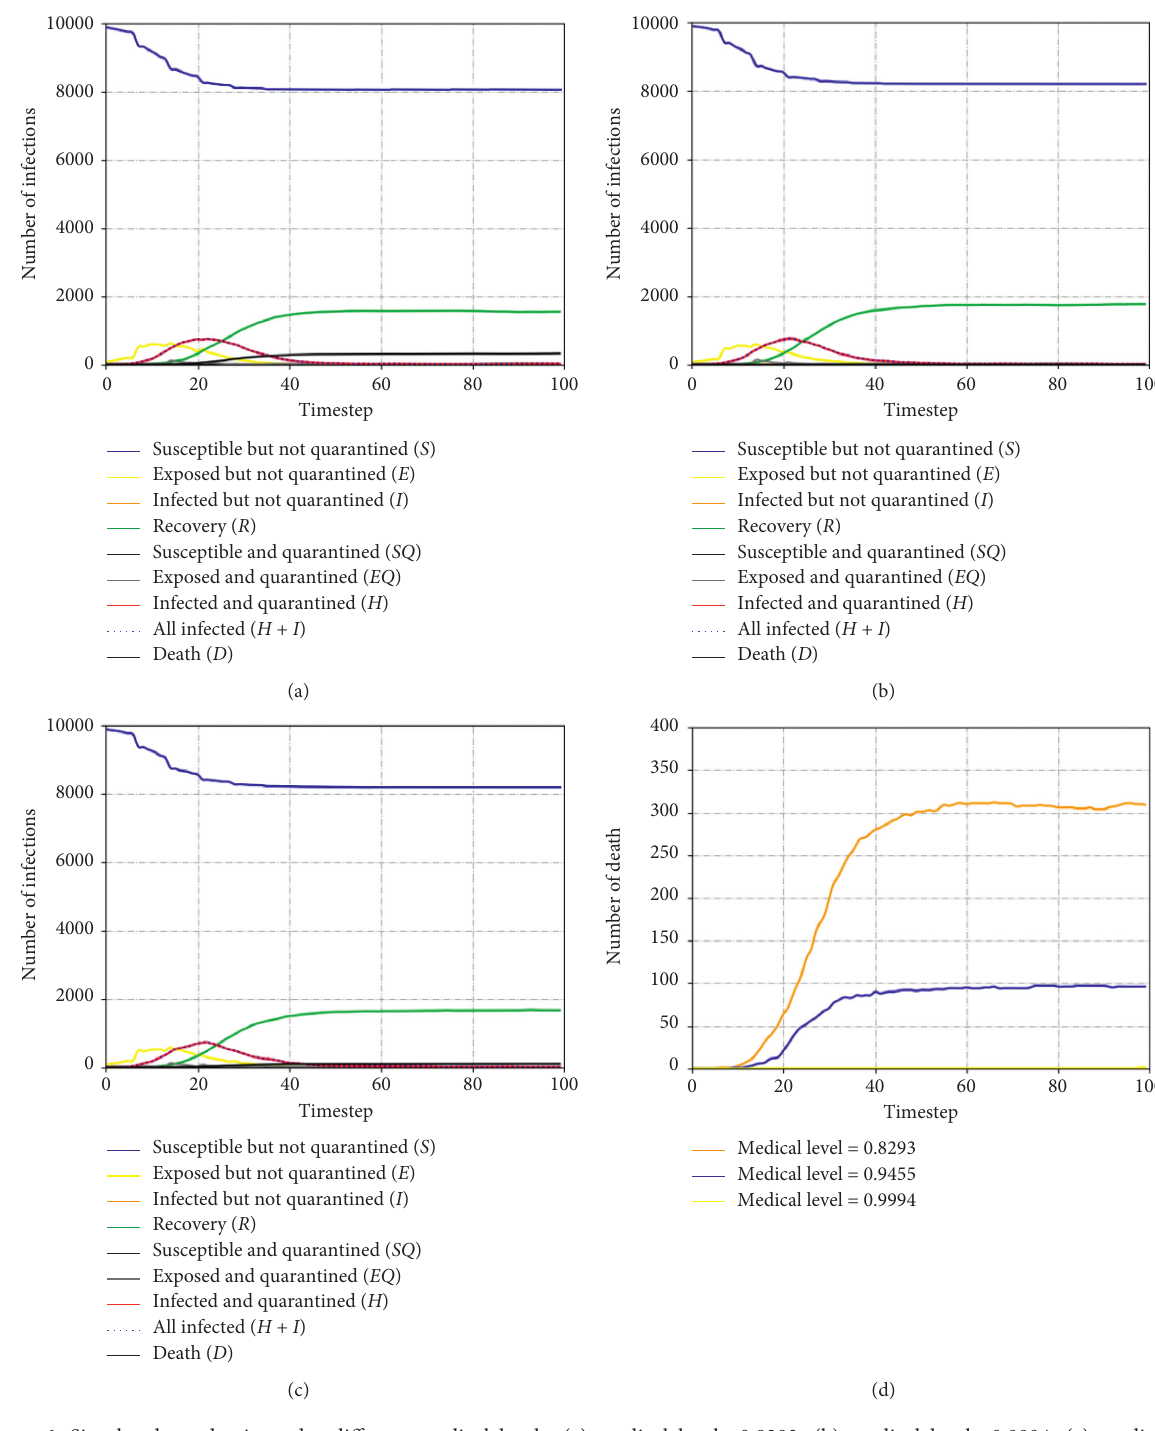
Figure 6: Simulated pandemic under different medical levels: (a) medical level � 0.8293; (b) medical level � 0.9994; (c) medical lev- el � 0.9455; (d) medical level comparison